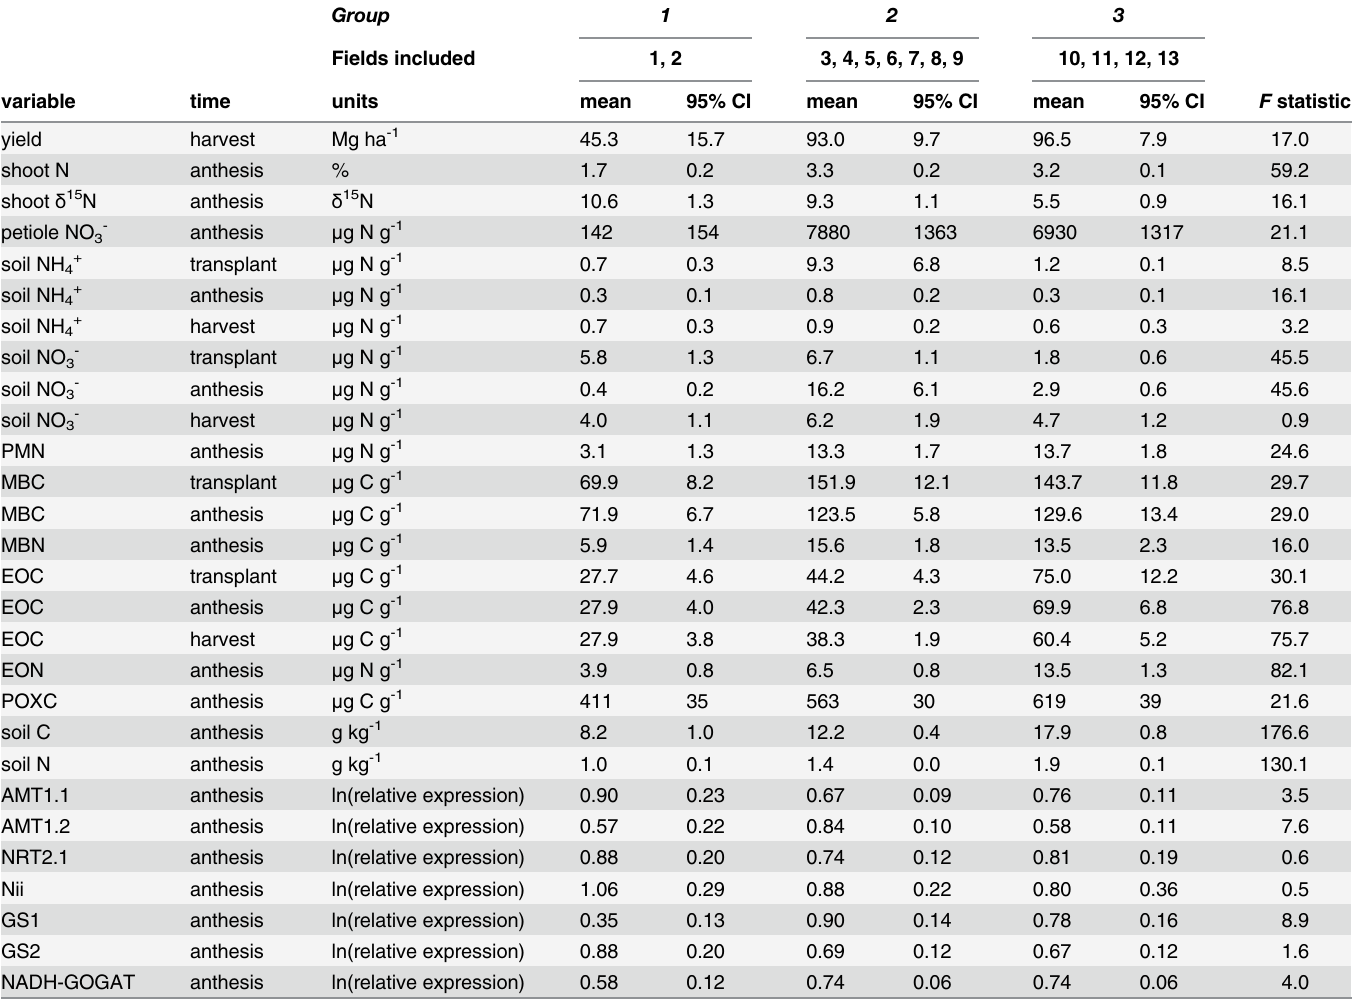
Table 4. Means and 95% confidence intervals of variables in each group of fields identified with k -means cluster analysis based on values of 28 plant, soil a , and root gene expression b variables measured across 13 organic Roma-type tomato fields in Yolo Co., California, USA. Group 1 2 3 Fields